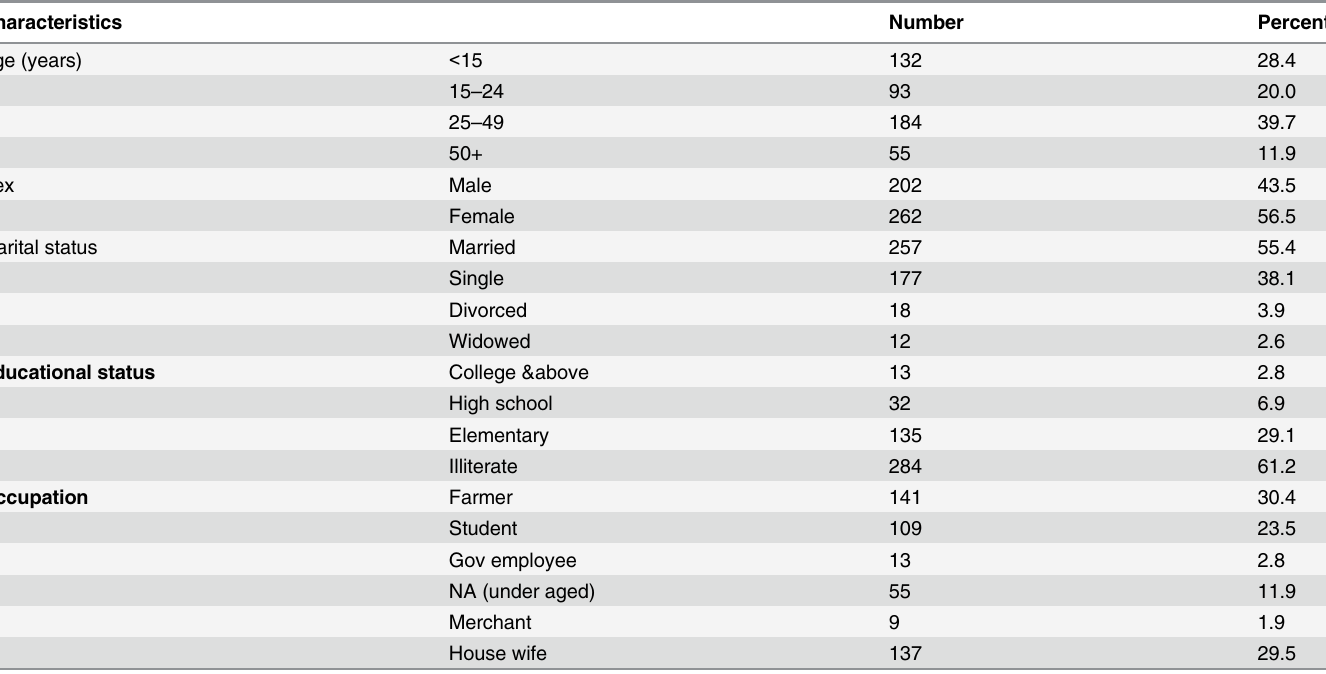
Table 1. Sociodemographic characteristics of study participants at Anbesame HC, 2015.